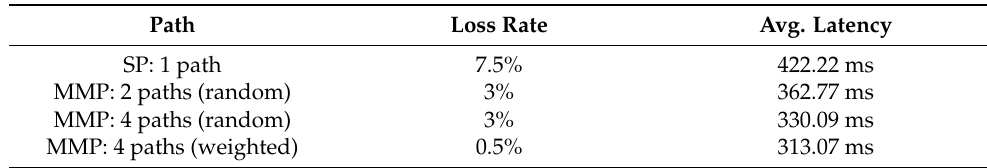
Figure 8. Latency comparison of SP and MMP routing. ‘MMP 4 paths’ (weighted/random) demon- strates selecting stable paths 4 times more than others and equally selecting all 4 paths by an attack (4–7 s). Table 2. Experimental results of an SP and MMP for the measurement of loss rates and latency during the